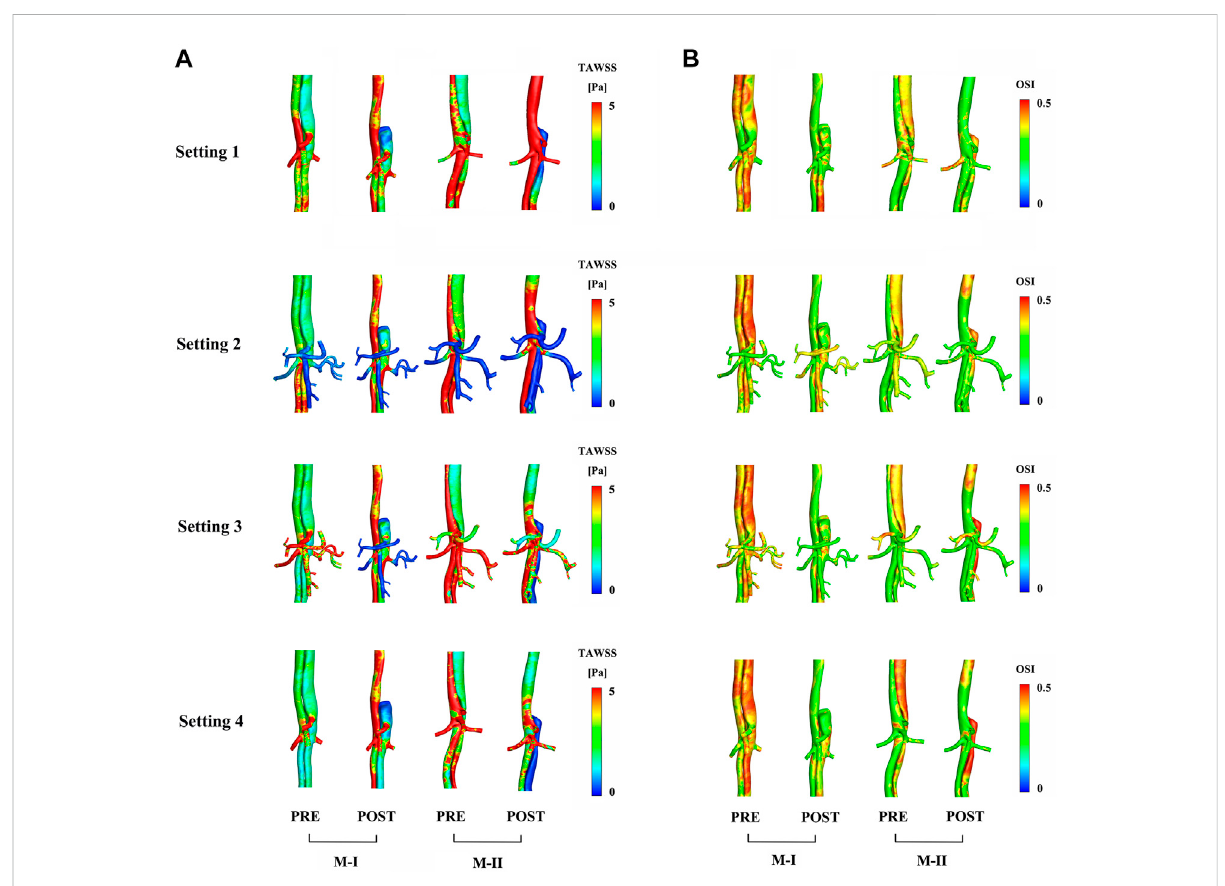
FIGURE 6 Comparison of (A) time-averaged wall shear stress and (B) oscillating shear index distribution between preoperative (pre) and postoperative (post)